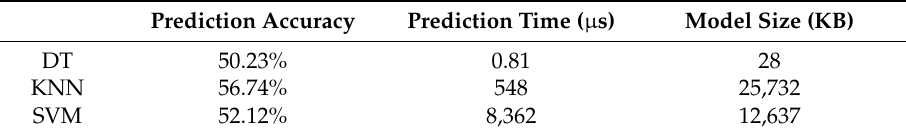
Figure 10. Comparison between two different numbers of features on vehicle mode detection accuracy of three machine learning algorithms. Table 7. General accuracy of each algorithm with seven features based on Reference [5].